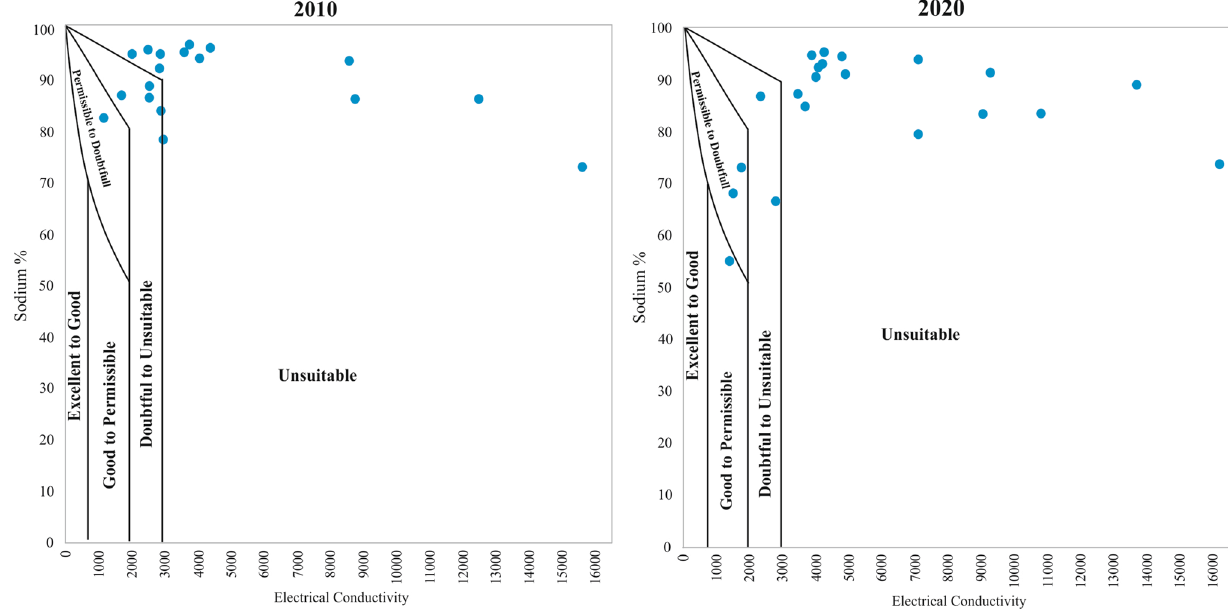
Fig. 7 Wilcox plot diagrams for the classification of groundwater based on electrical conductivity (µs/cm) and sodium % for 2010 and